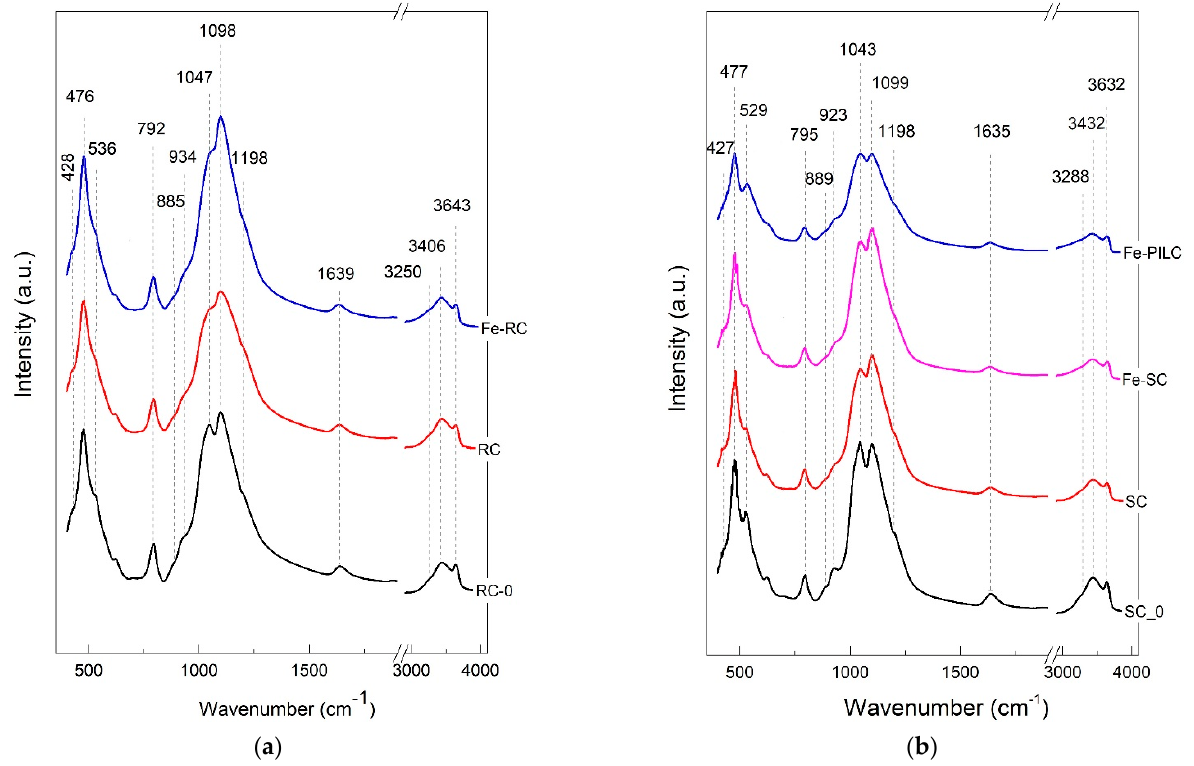
Figure 2. FTIR spectra of ( a ) RC-0, RC, Fe-RC; ( b ) SC-0, SC, Fe-SC, and Fe-PILC clay samples.